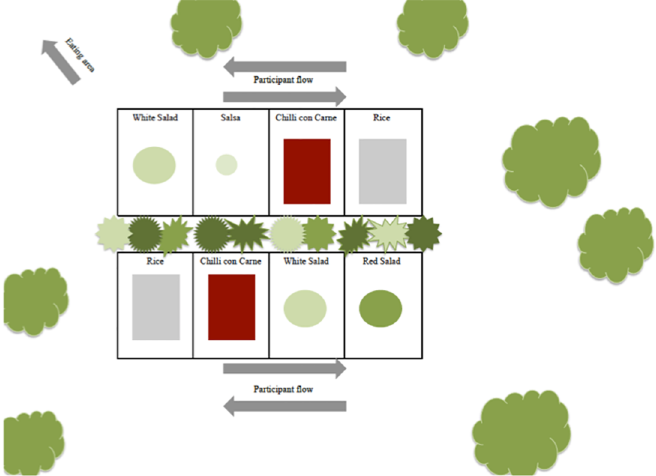
Fig 2. Visual presentation of the experimental setting: Priming. A green ambiancewas created using plants and herbs.